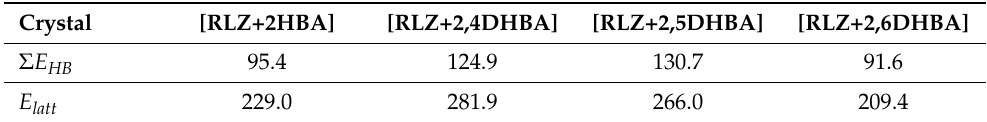
Table 2. Total energy of intermolecular H-bonds in the crystals of RLZ salts obtained using Equation (2), and lattice energy estimated using Equation (3). Geometric parameters were calculated at the PBE-D3 level. The units are kJ · mol − 1 .